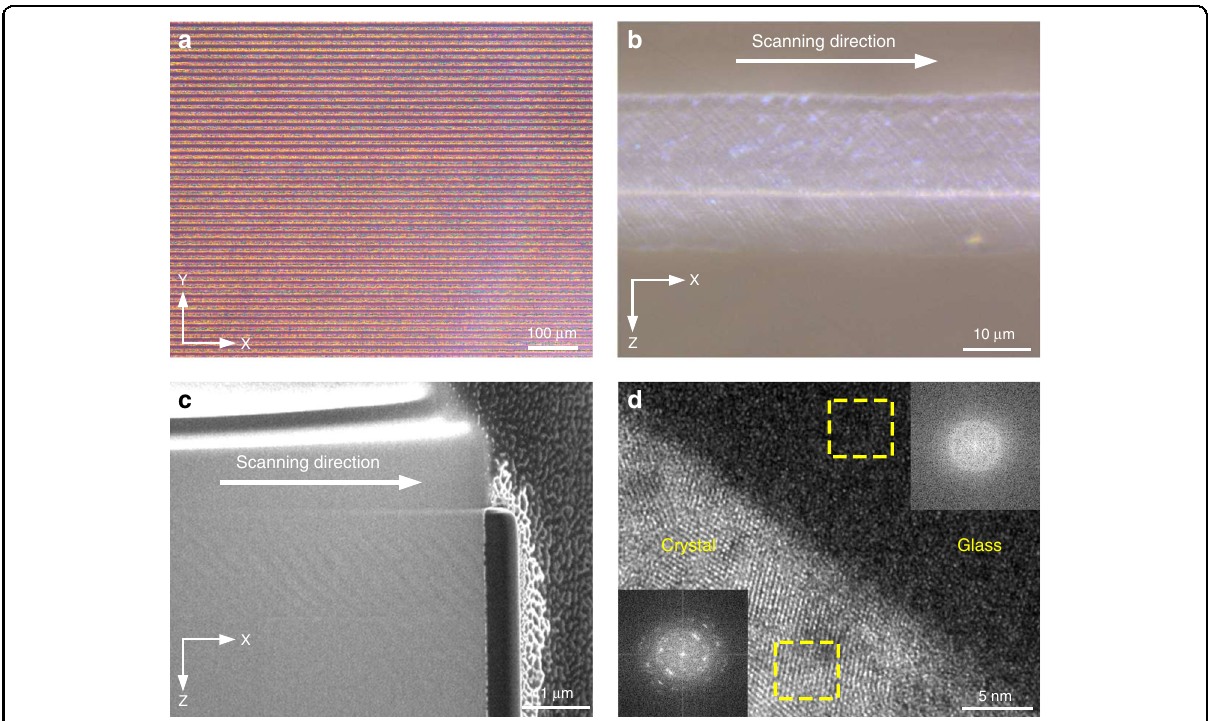
Fig. 3 Structural demonstration of the textures. a Birefringence image of largely produced photonic textures in the glass. b Optical microscope image of the embedded glass-crystal arrays without any mechanical damage. c Focused ion beam (FIB) slice of the periodic glass-crystal arrays of the texture. d HRTEM image of the glass and crystal region of the texture. Insets are the fast Fourier transform (FFT) images of the dotted